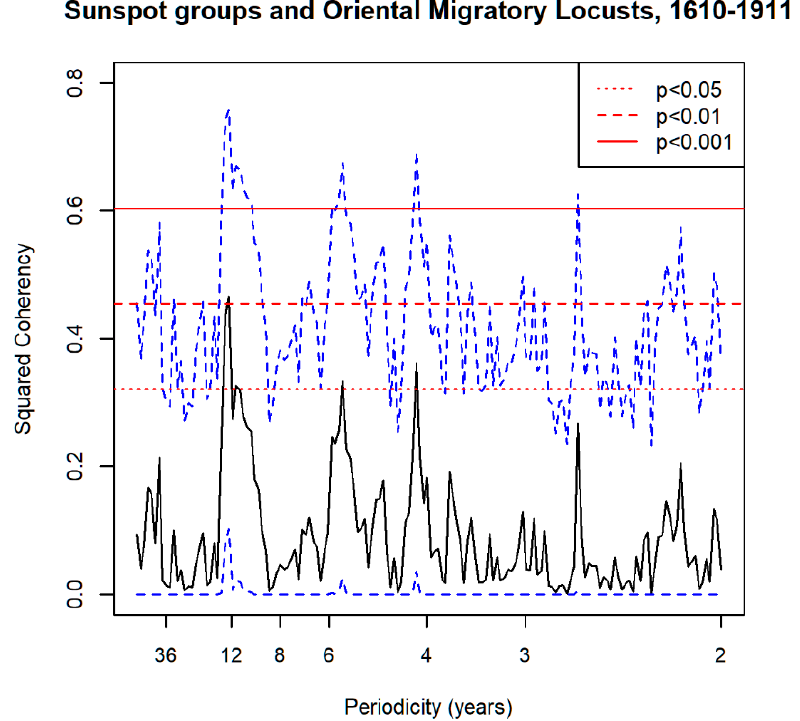
Figure 9. Spectral coherence between sunspot groups and Oriental Migratory Locusts, 1610–1911. The solid horizontal red line indicates significance at p = 0.001, dashed line p = 0.05, dotted line p = 0.05. The blue dotted lines represent 95% confidence intervals.